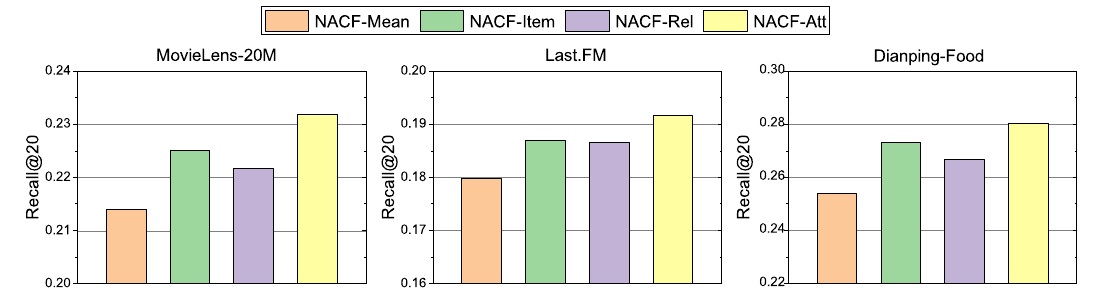
Figure 6. Performance under different attention